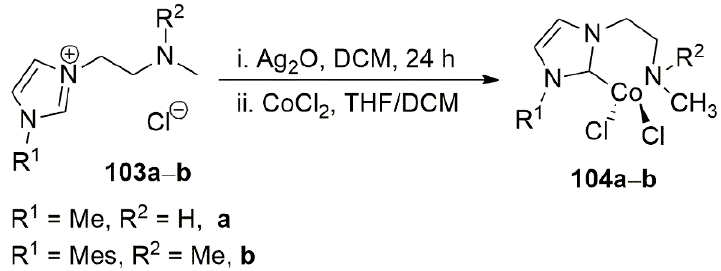
Molecules 2022 , 27 , x FOR PEER REVIEW 20 of 73 Scheme 25. Ru(II) complexes with NHC ‐ C ligands [147]. Out of five metal complexes, 101b proved to be an ideal catalyst in the TH of acetophenone in a basic i PrOH. Under optimized reaction conditions, hydrogenation of a series of aromatic and aliphatic ketones were carried out with high reactions rates (up to 97% in 2 h, in some cases) at low catalyst loading (0.1 mol%). Being a congener of the catalytically important precious metals rhodium and iridium, cobalt has also attracted a lot of attention mainly because of its lesser toxicity and higher natural abundance. Well ‐ defined complexes of cobalt with amine, phosphine and in recent years with NHC ligands were applied as catalyst in the hydrogenation of a variety